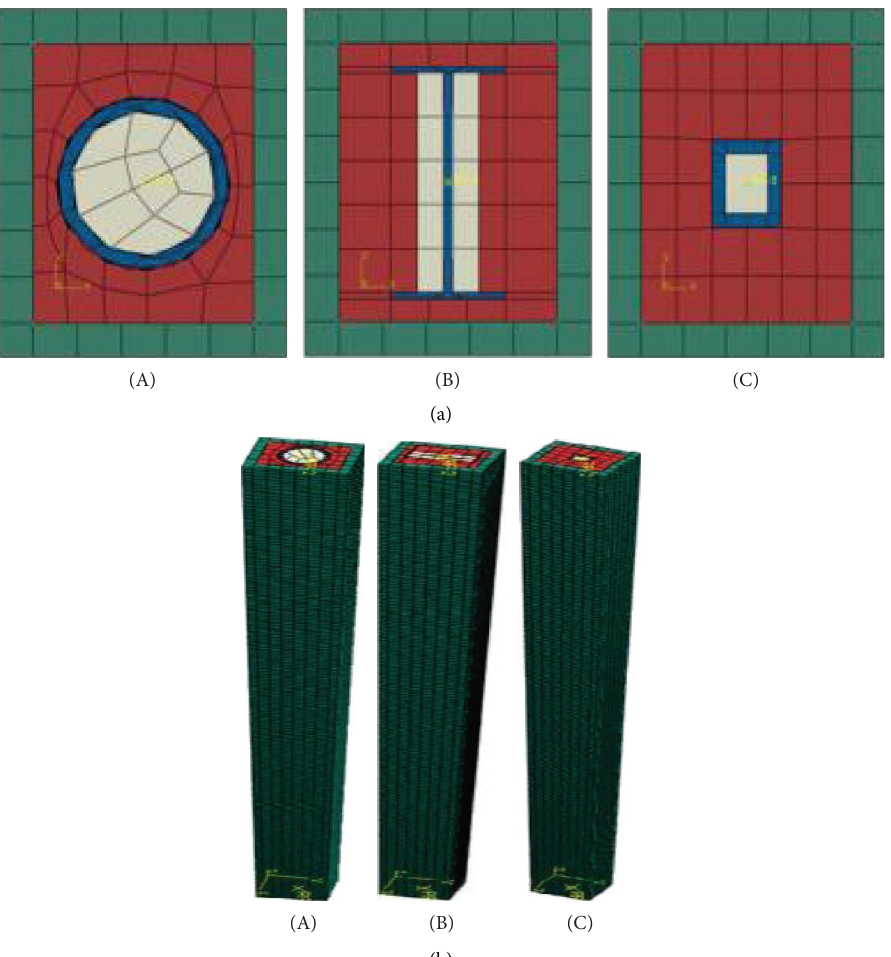
Figure 3: Geometry of FEC column specimens. (a) Plan view of (A) circular, (B) I-shaped, and (C) rectangular steel encasements for FEC column and (b) 3D View of (A) circular, (B) I-shaped, and (C) rectangular steel encasements for FEC